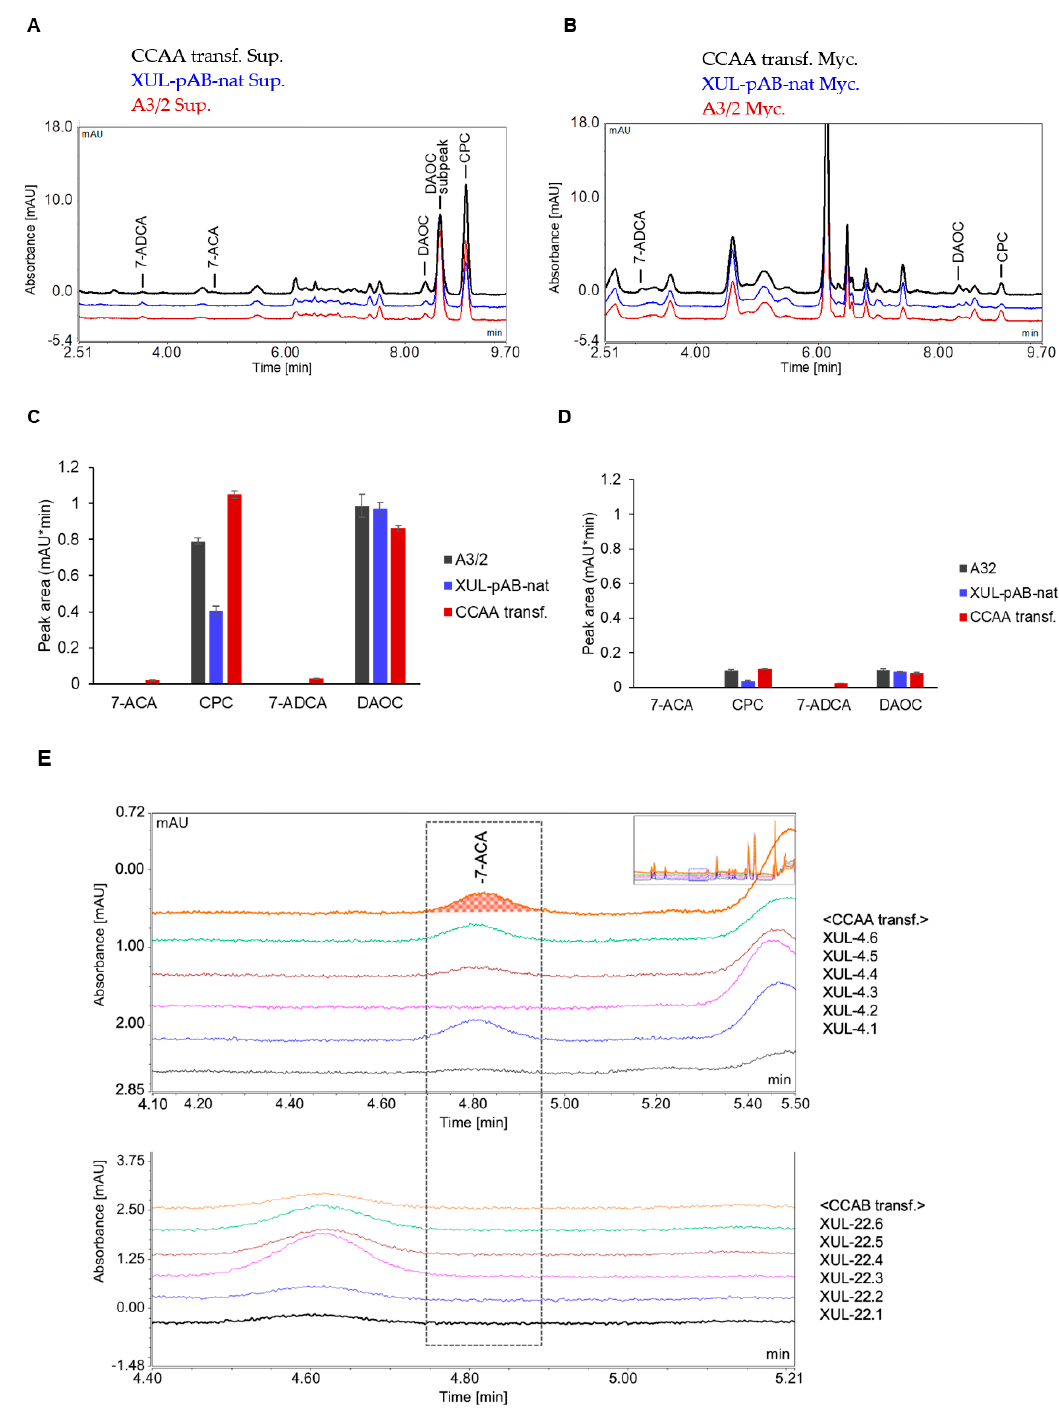
Figure 7. HPLC analysis of fungal mycelia and culture supernatants to separately detect com- pounds related to the CPC biosynthesis pathway. ( A ) HPLC spectrum of fungal culture supernatants. ( B ) HPLC spectrum of concentrated mycelial extracts prepared as described in the Materials and Methods section. ( C , D ) HPLC peak areas of selected substances detected in the supernatants ( C ) and mycelial samples ( D ). ( E ) Detection of 7-ACA in the culture supernatants of randomly selected CCAA and CCAB transformants as indicated. For HPLC measurements, fungal mycelia and culture supernatants from 6 days cultures were separated by vacuum filtration. The sample preparation process was followed as described in the Material and Methods